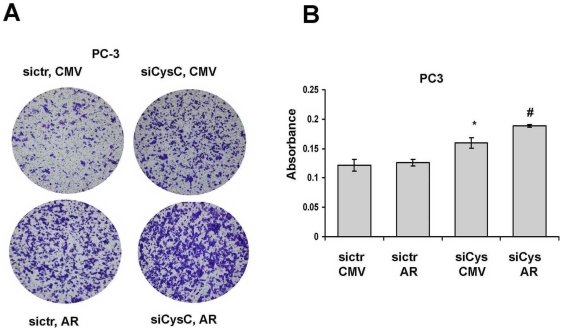
AR regulates the invasion in the absence of cystatin C.
A–B). Invasion assay of PC3 cells transfected with control siRNA or against cystatin C and coexpressing AR. The pictures from representative experiment are shown in A and the quantitative absorbances of invading cells (*p<0.05, cystatin C siRNA versus siRNA control, #p<0.05 AR versus CMV, Student T-test) after stating with Cell Stain Solution supplied in the Transwell Invasion assay (Chemicon, Millipore, CA) are shown in B. The data are representative for 3 independent experiments.